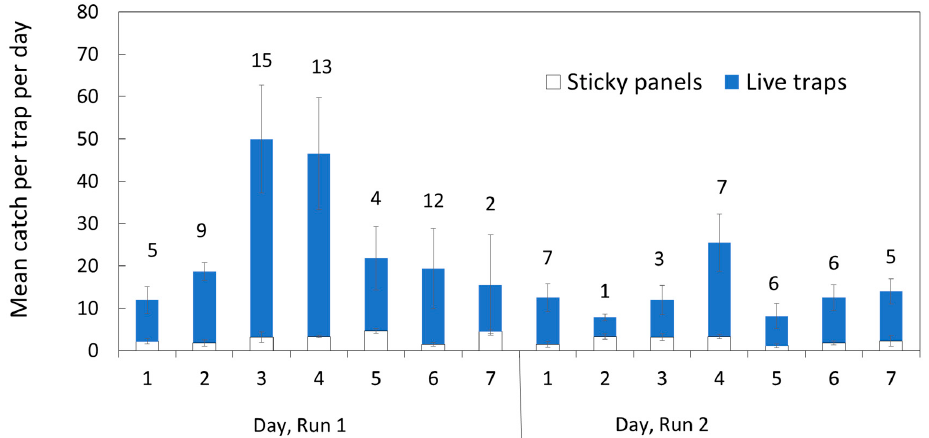
Figure 2. Mean daily catch per trap of adult Halyomorpha halys in alternating sticky panels and live traps, on a vineyard–forest margin at Fondazione Edmund Mach, San Michele all’Adige (TN), Italy. Error bars show one standard error (n = 6 replicates). Runs 1 and 2 were at different locations, 200 m apart. Labels indicate the mean improvement in catch from the live traps over sticky panels.